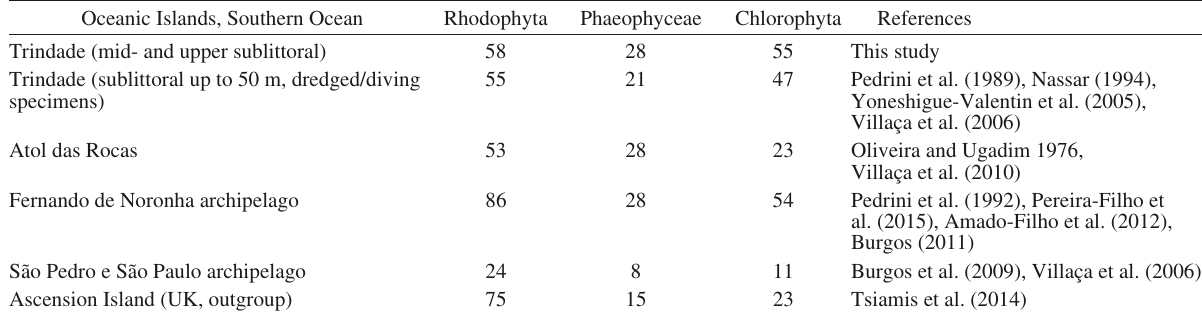
Table 3. – Comparison of studies from the southern Atlantic oceanic islands, considering macroalgae richness by groups (Rhodophyta, Phaeophyceae and Chlorophyta). Oceanic Islands, Southern